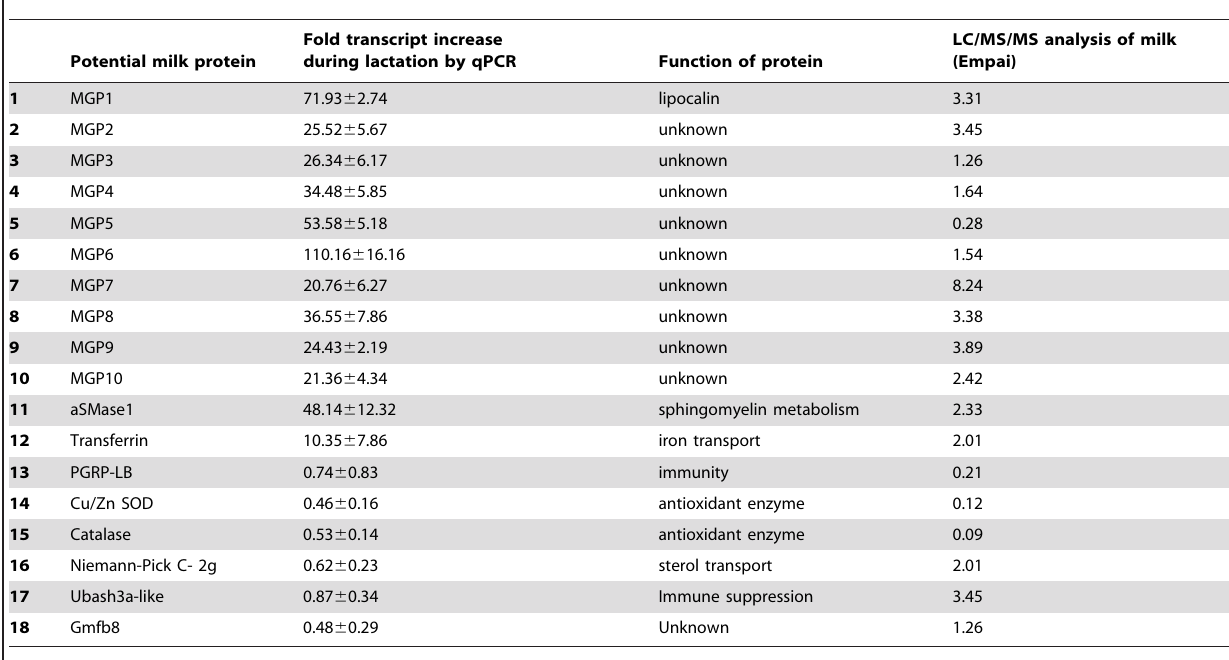
Table 2. Specific proteins documented in tsetse milk based by LC/MS/MS or expressed highly in the transcriptome study.